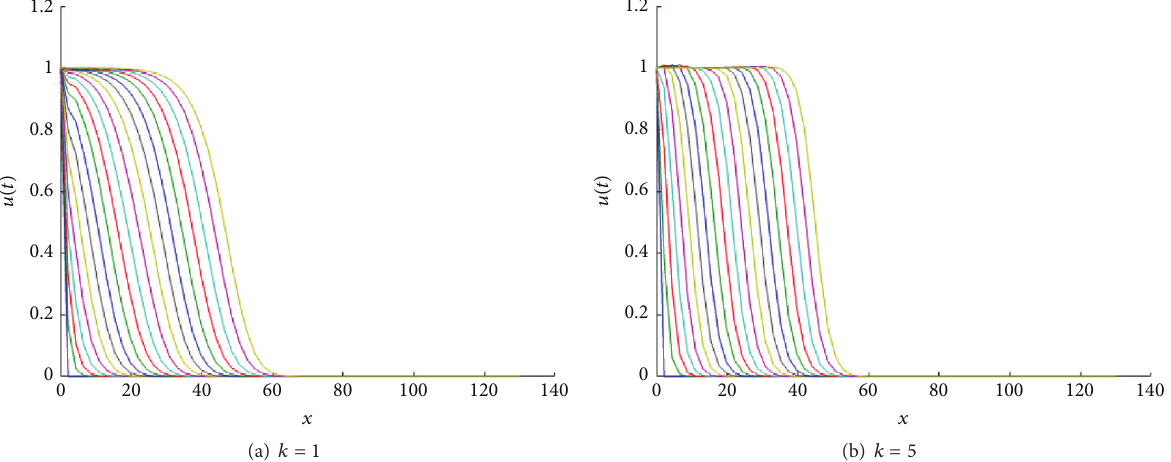
Figure 8: Front traveling waves solutions of (14) at equal time intervals 𝑡 = 1, 2, 3,. .. with 𝑔(𝑢) = 𝑢(1 − 𝑢) and 𝐷(𝑢) = 𝑢(1.0 + 𝛽𝑢) for 𝛽 = 1 . The values for 𝑘 are indicated in each figure.